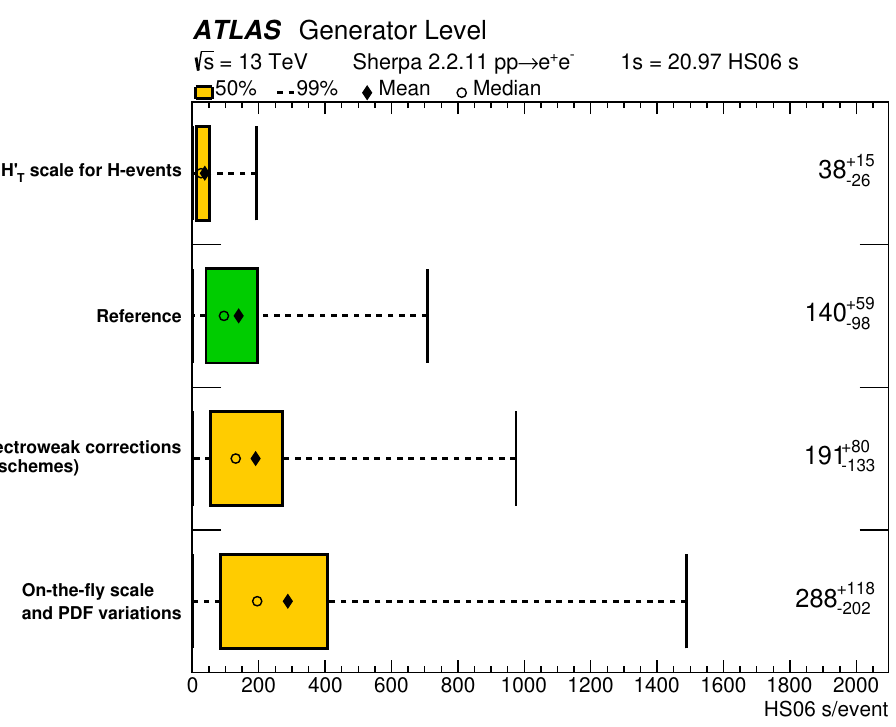
Figure 8 . The time in HS06 seconds per event for various features that affect the event generation time. The markers show the mean and median values, and the box shows the ± 25% quantiles. The whiskers show the 99% containment bounds, while the numbers on the right show the mean and standard deviation of the sample. All set-ups are accurate to 0–2j@NLO+3,4,5j@LO in the QCD coupling. One second equals 20.97 HS06 seconds on the specific machine